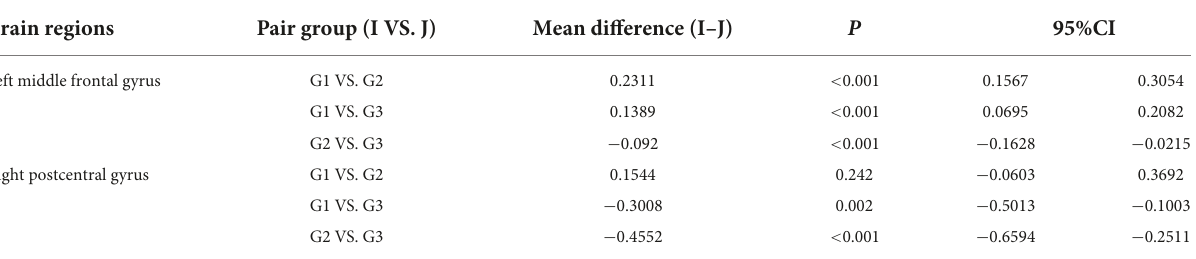
TABLE 3 Multiple comparisons of ALFF in left middle frontal gyrus and right postcentral gyrus. Brain regions Pair group (I VS.